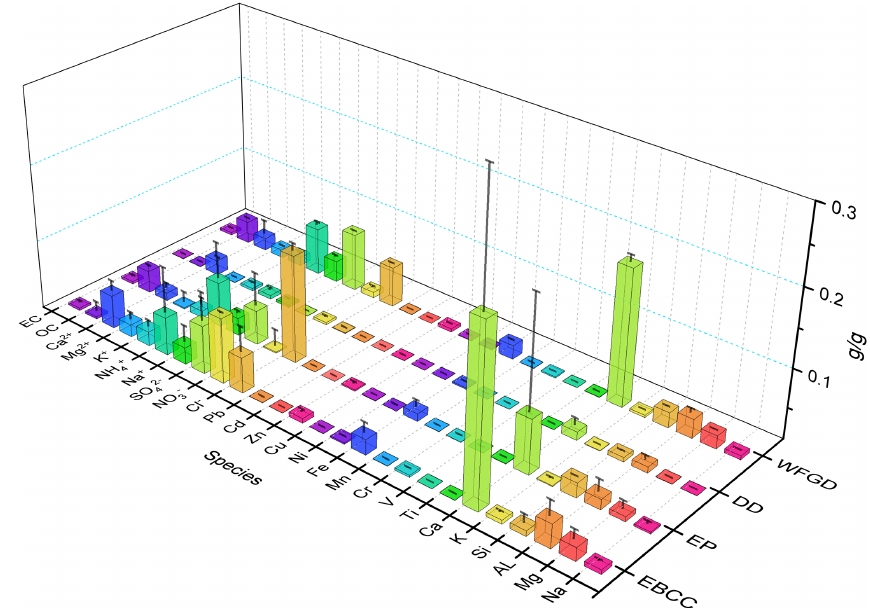
Figure 3. Comparison of PM 2 . 5 source profiles collected using different dust removal and desulfurization facilities. WFGD denotes wet flue gas desulfurization, DD denotes dry desulfurization, EP denotes electrostatic precipitators, and EBCC denotes electric bag compound dust collectors. Data from the Nankai University source library were collated.